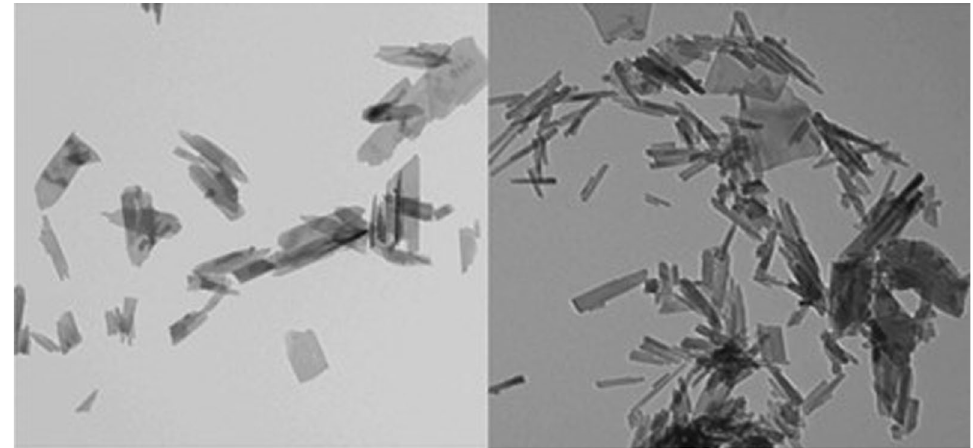
Fig. 2 TEM showing nano calcium phosphate particles indicating needle-like crystals with width (25